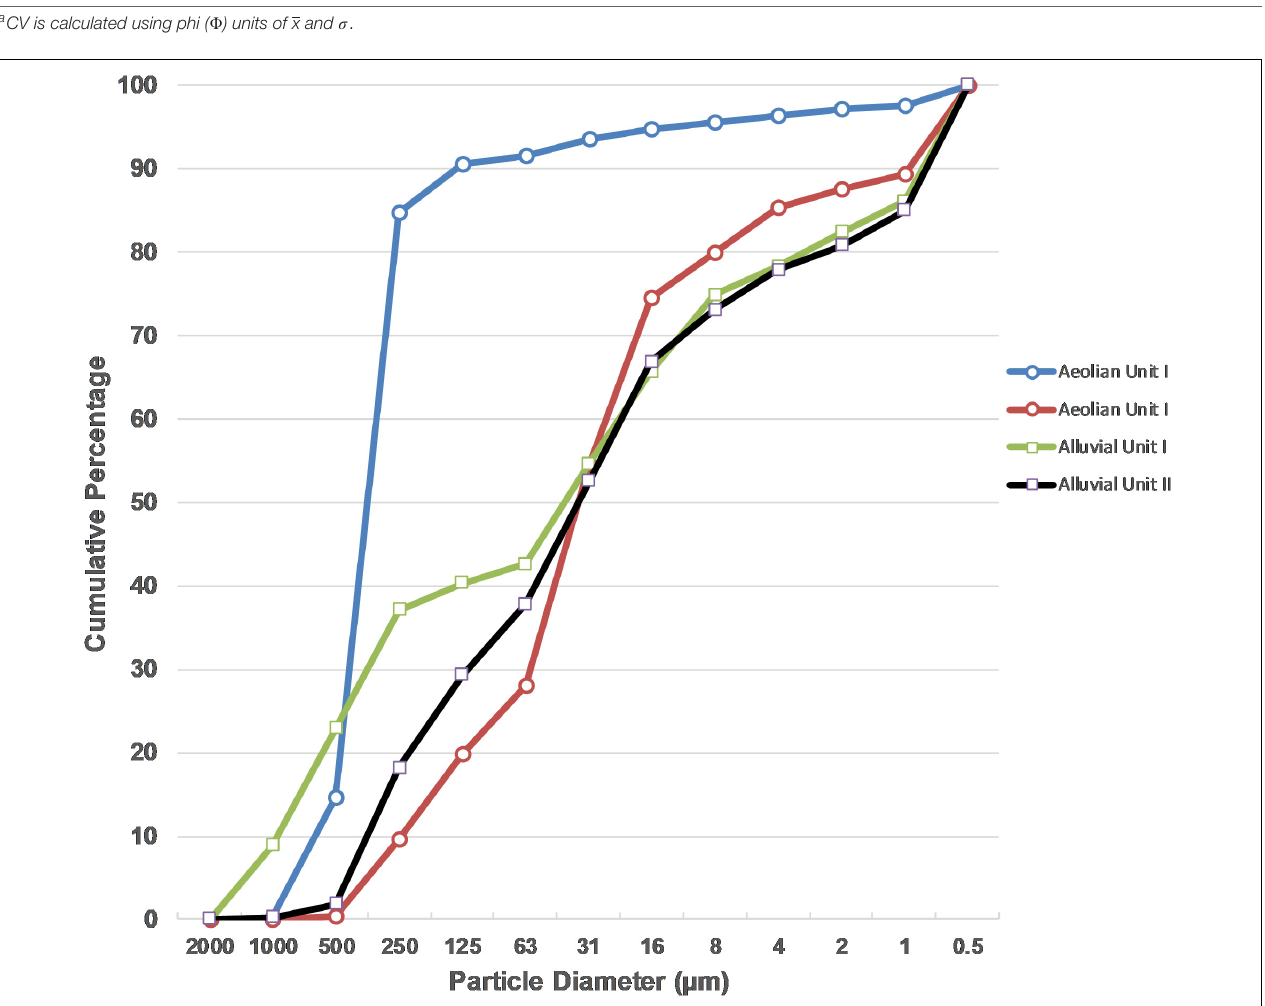
FIGURE 7 | Cumulative frequency graph of grain sizes per facies type (Aeolian Unit I and II and Alluvial Unit I and II). Graph based on all 163 sediment